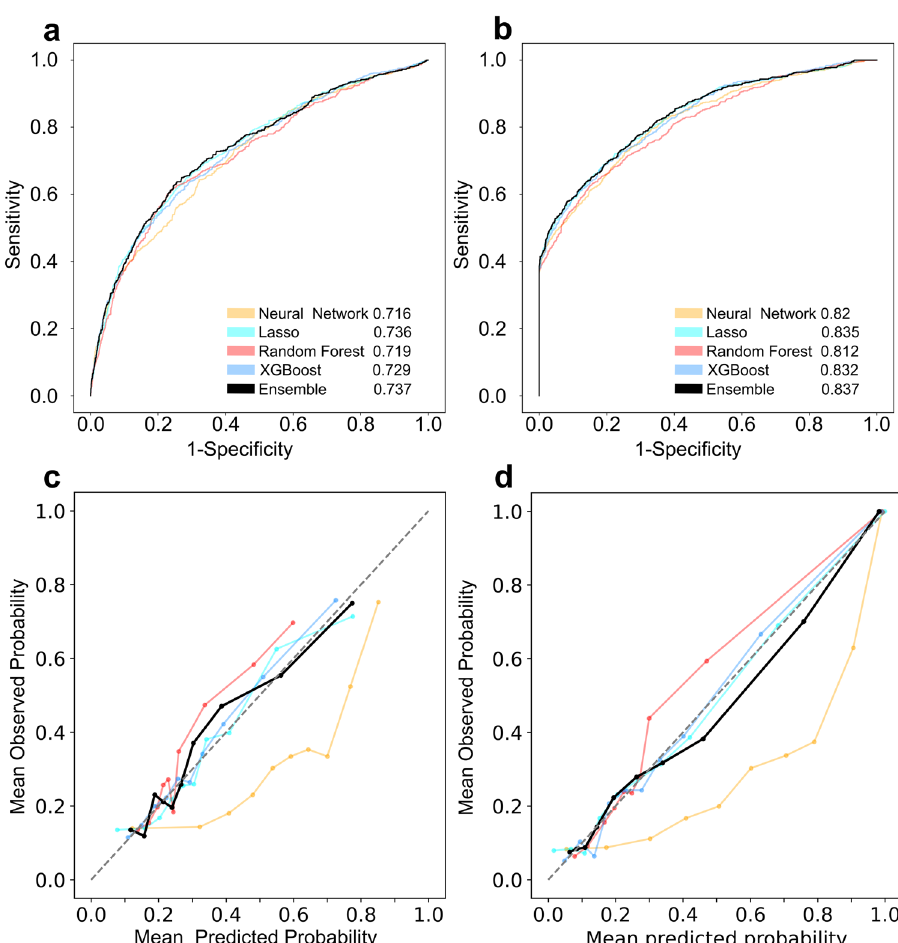
Fig. 2 ROC curves and calibration plots for bacteria-agnostic and bacteria-gnostic datasets. a ROC curve for bacteria-agnostic dataset, b ROC curve for bacteria-gnostic dataset c calibration plot for bacteria-agnostic dataset, d calibration plot for bacteria-gnostic dataset. ROC-AUC results of each model, on the test set, are presented within a and b . The colors represent different algorithms, where the black bold lines are the results of the ensemble model. Data points presented on the calibration plots are aggregated by deciles of predicted